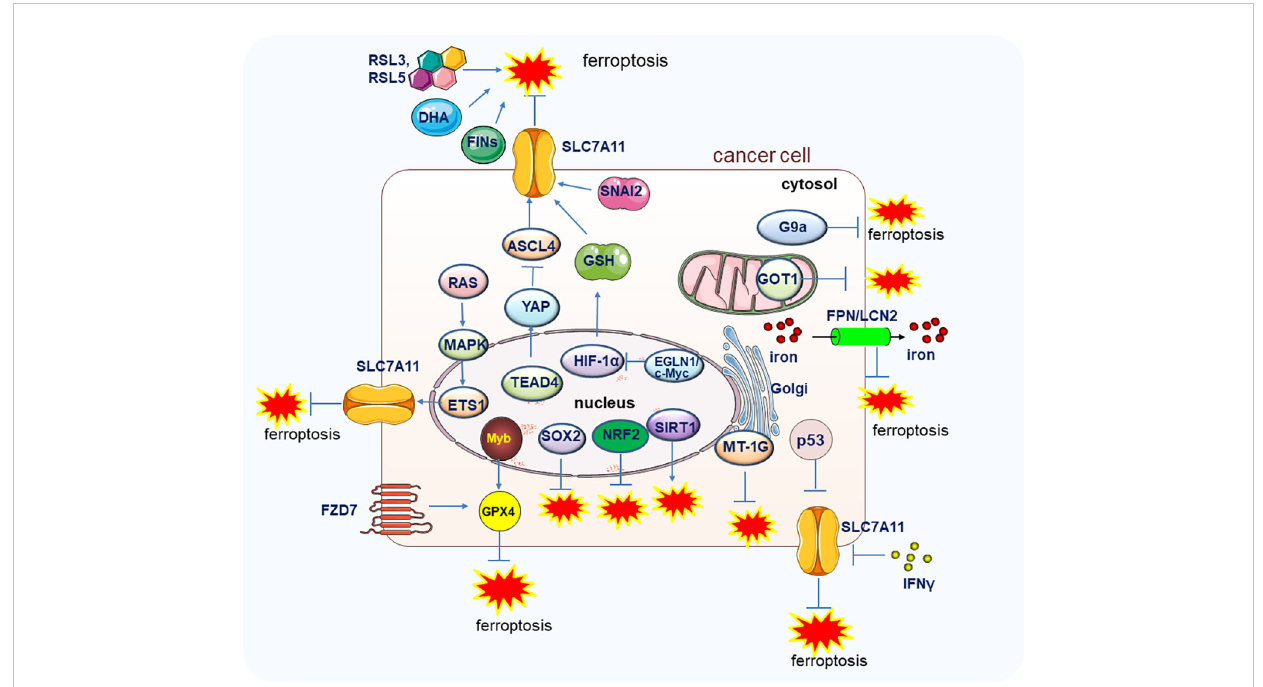
FIGURE 2 The genes and pathways involved in the regulation of ferroptosis in tumor cells. Main genes and signal pathways involved in the regulation of ferroptosis in tumors cells are